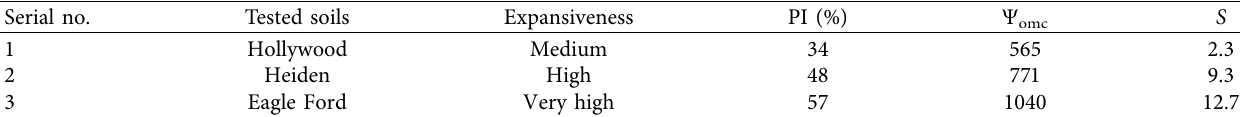
Table 9: Specification of independent test soils incorporated for validation of swell potential models.